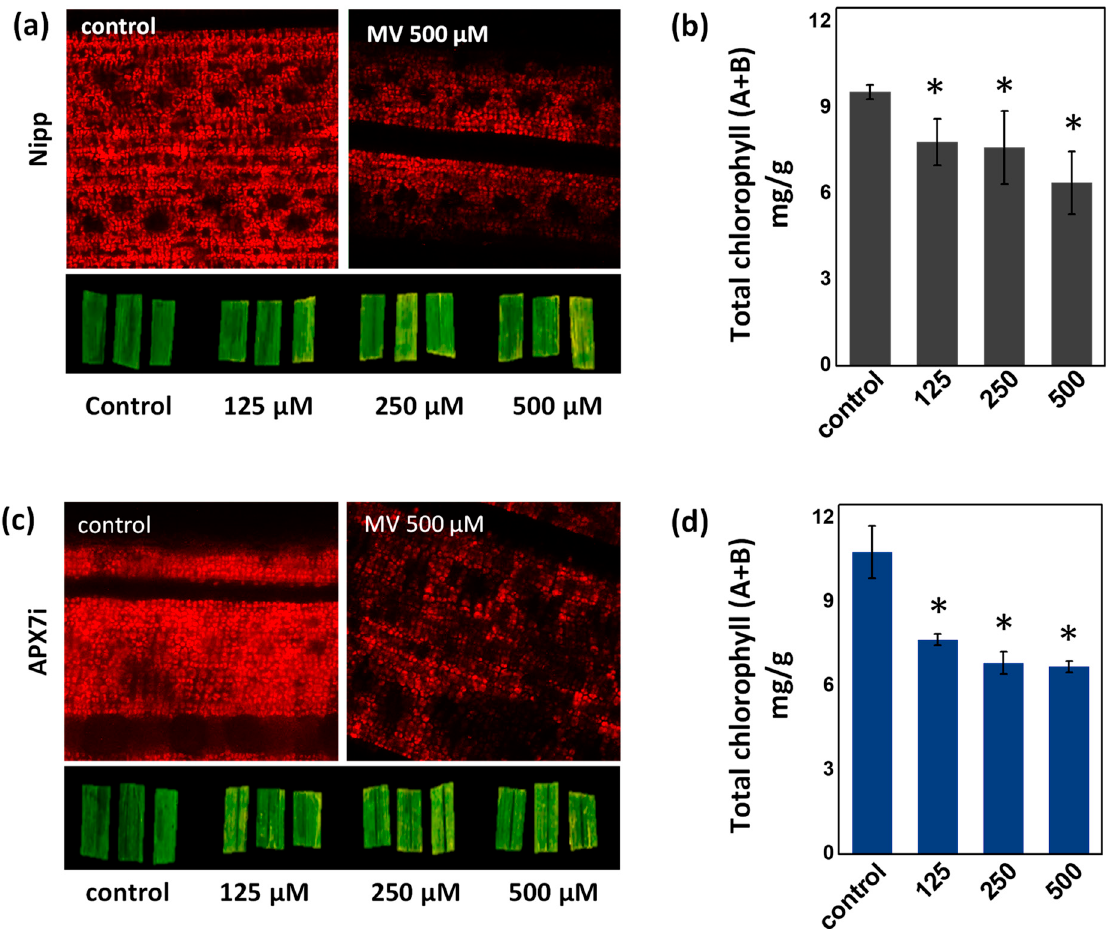
Figure 4. Effect of MV treatment in the chlorophyll content of Nipp plant leaves evaluated by fluorescence microscopy ( a ) and quantified by colorimetric method ( b ). Effect of MV treatment in the chlorophyll content of APX7i plant leaves evaluated by fluorescence microscopy ( c ) and quantified by colorimetric method ( d ). The values represent the average ± SE of at least four independent experiments. * indicates populations significantly different from the control situation with p < 0.05.